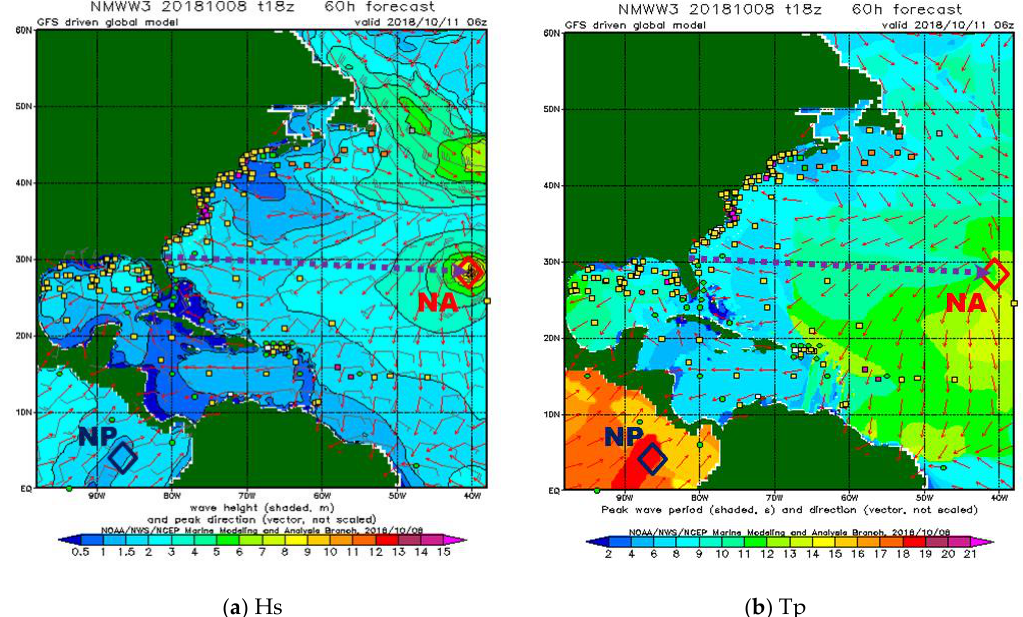
Figure 2. NOAA forecast snapshot for North West Atlantic [10] .